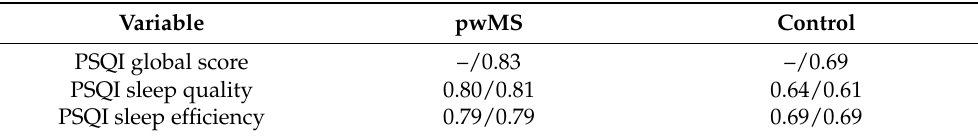
Table 3. Reliability of PSQI scores in pwMS ( n = 79) and control subjects ( n = 213) expressed as McDonald’s omega/Cronbach’s alpha.